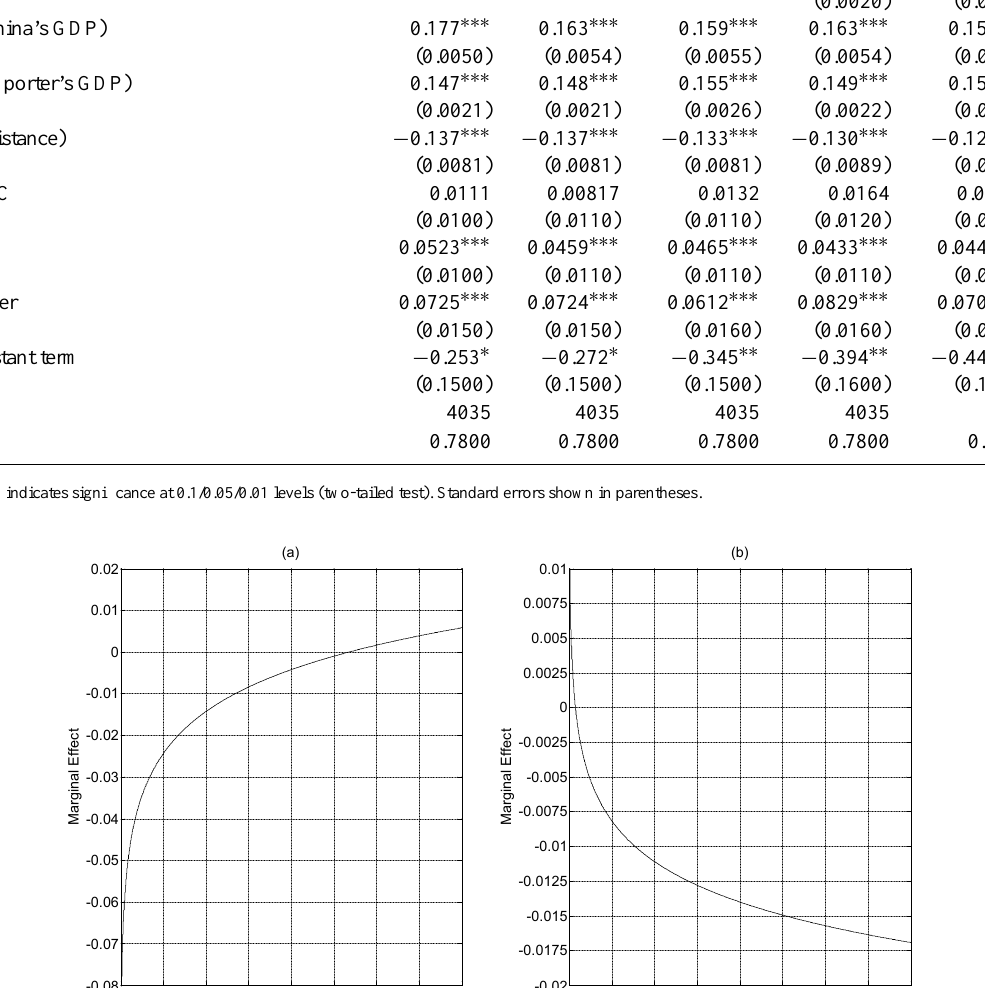
Figure 3. Marginal effect of natural disasters in partner countries on China’s bilateral trade as a function of land area. (a) is for China’s imports; (b) is for its